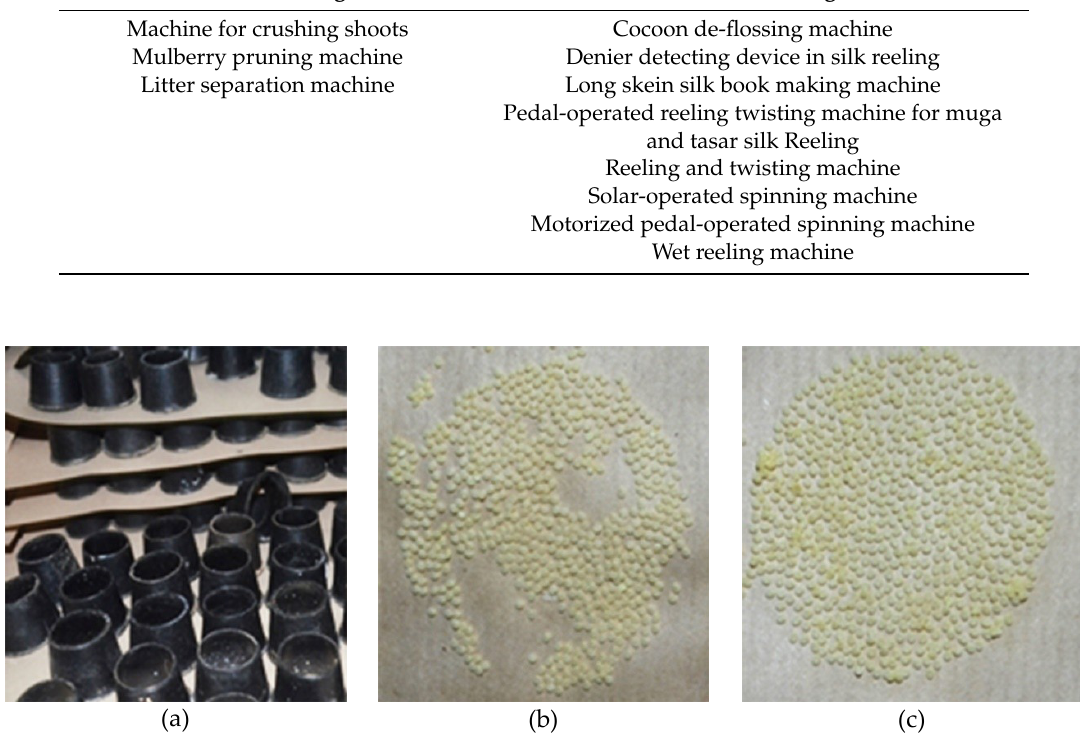
Figure 2. ( a ) Image of cubicles used for egg production. ( b ) Eggs produced by incorrect separation of cocoons. ( c ) Eggs produced by pairing best male and female cocoons. Table 2. Methods for silkworm gender classification for di ff erent stages